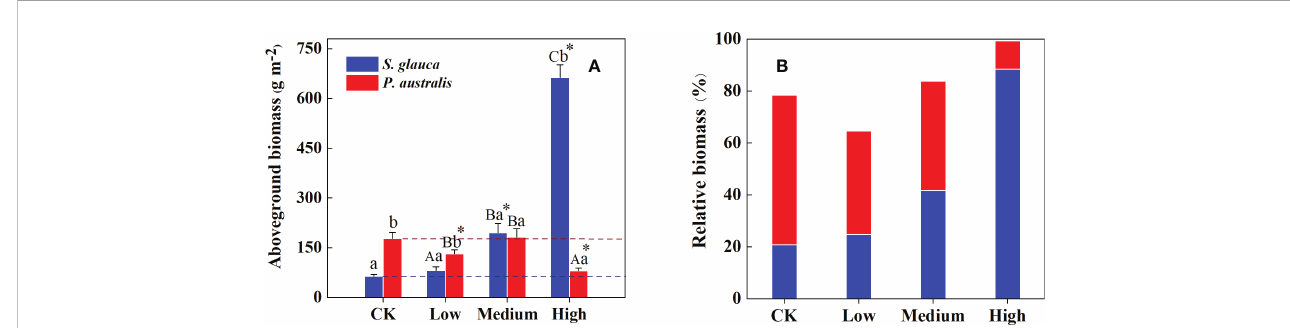
FIGURE 4 Mean aboveground biomass (A) and relative biomass (B) of S. glauca and P. australis under different treatments. Data show the mean ± SE (supply level treatment, n=12; control treatment, n=6). Different capital letters represent signi fi cant differences in plant biomass among the three supply level treatments at the 0.05 level. Different lowercase letters represent signi fi cant differences between S. glauca and P. australis under the same treatments at the 0.05 level. * denotes a signi fi cant difference between the control treatment and the supply level treatment at the 0.05